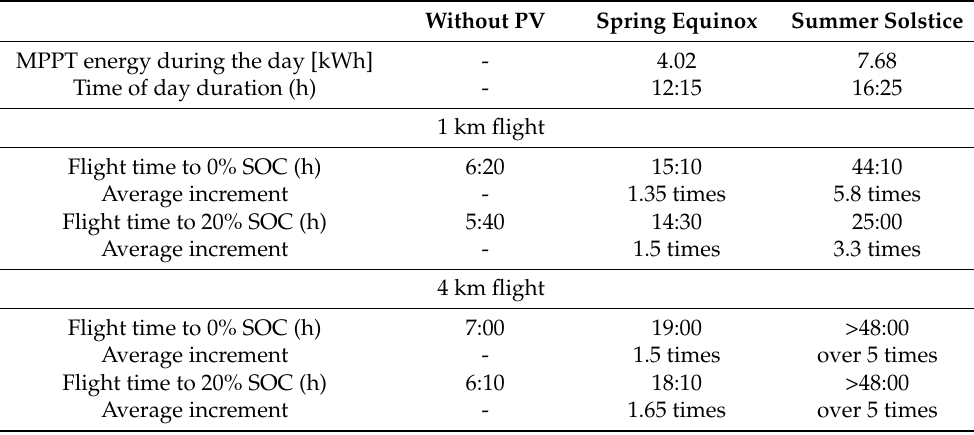
Table 2. VTOL flight